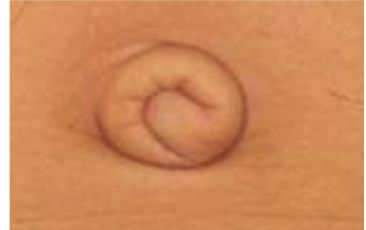
Figure 7: Protuberant umbilicus in patient